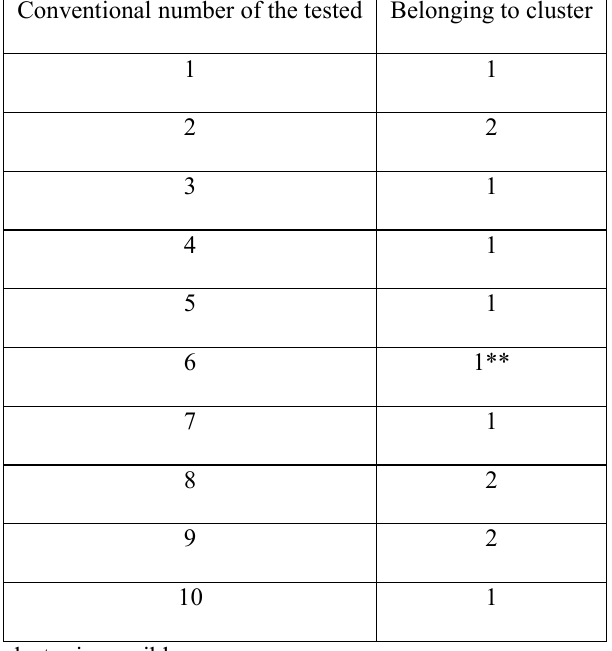
psycho-physiological indicators Conventional number of the tested Belonging to